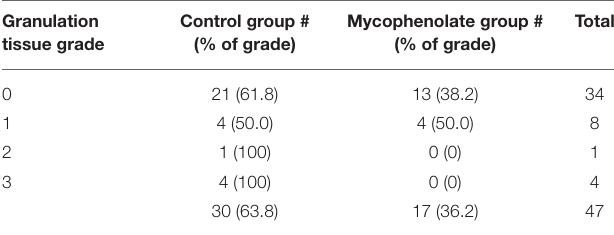
TABLE 6 | Presence and severity of granulation tissue at 6 month ± 2 week time point.